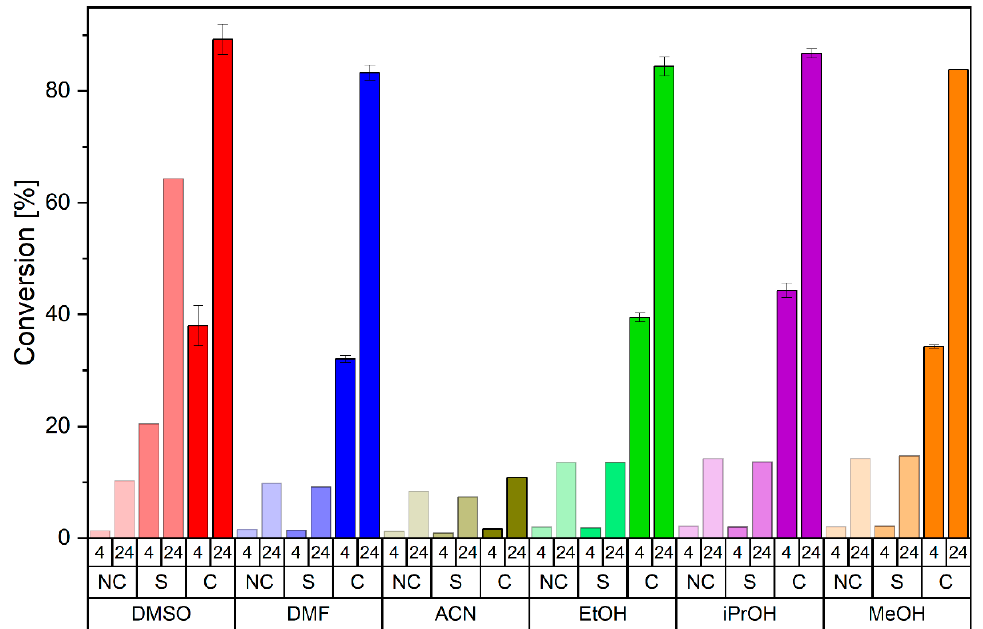
Figure 6. Conversion of 20 mM cyclohexene oxide and 40 mM azide in the presence of 25% ( v / v ) water-miscible organic solvents using either 100 µg V46K CLECs or soluble enzyme. Investigated solvents were dimethyl sulfoxide (DMSO), dimethyl formamide (DMF), acetonitrile (ACN), ethanol (EtOH), isopropanol (iPrOH) and methanol (MeOH). Samples were taken after 4 and 24 h. Reactions were performed in duplicates. ‘NC’ indicates negative control without enzyme, ‘S’ soluble enzyme and ‘C’ CLECs.